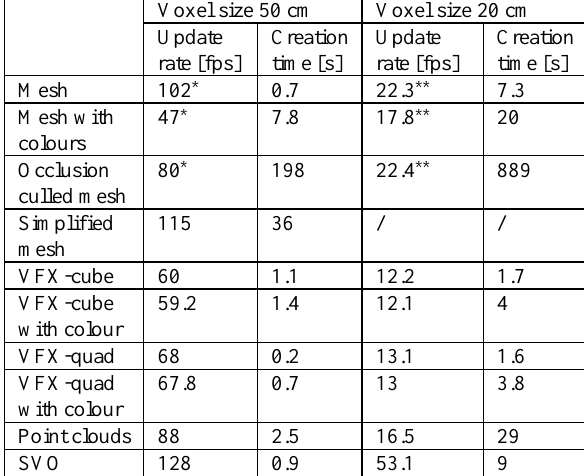
Table 3 . Comparison of voxel visualisation approaches; * 32 3 blocks used; ** 128 3 blocks used.